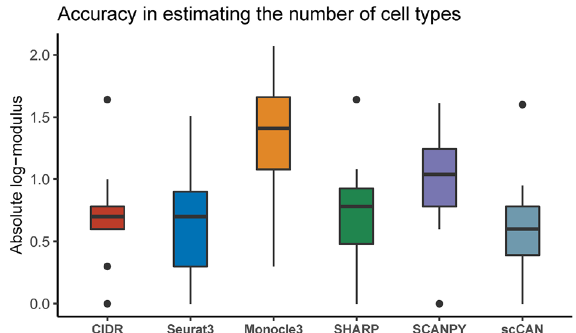
Figure 2. Absolute log-modulus values obtained from CIDR, SEURAT3, Monocle3, SHARP, SCANPY, and scCAN for 27 real scRNA-seq datasets. This metric measures the difference between the number of clusters and the number of true cell types. The average log modulus of scCAN is 0.59 while those of Monocle3, SCANPY, SHARP, SEURAT3, and CIDR are 1.35, 1, 0.72, 0.64, and 0.63, respectively. scCAN significantly outperforms other methods by having the smallest absolute log-modulus values (Wilcoxon p -value of p = 8.6 × 10 − 4 ). Note that the dataset Brain 1.3M was excluded from this analysis because it does not have true cell type